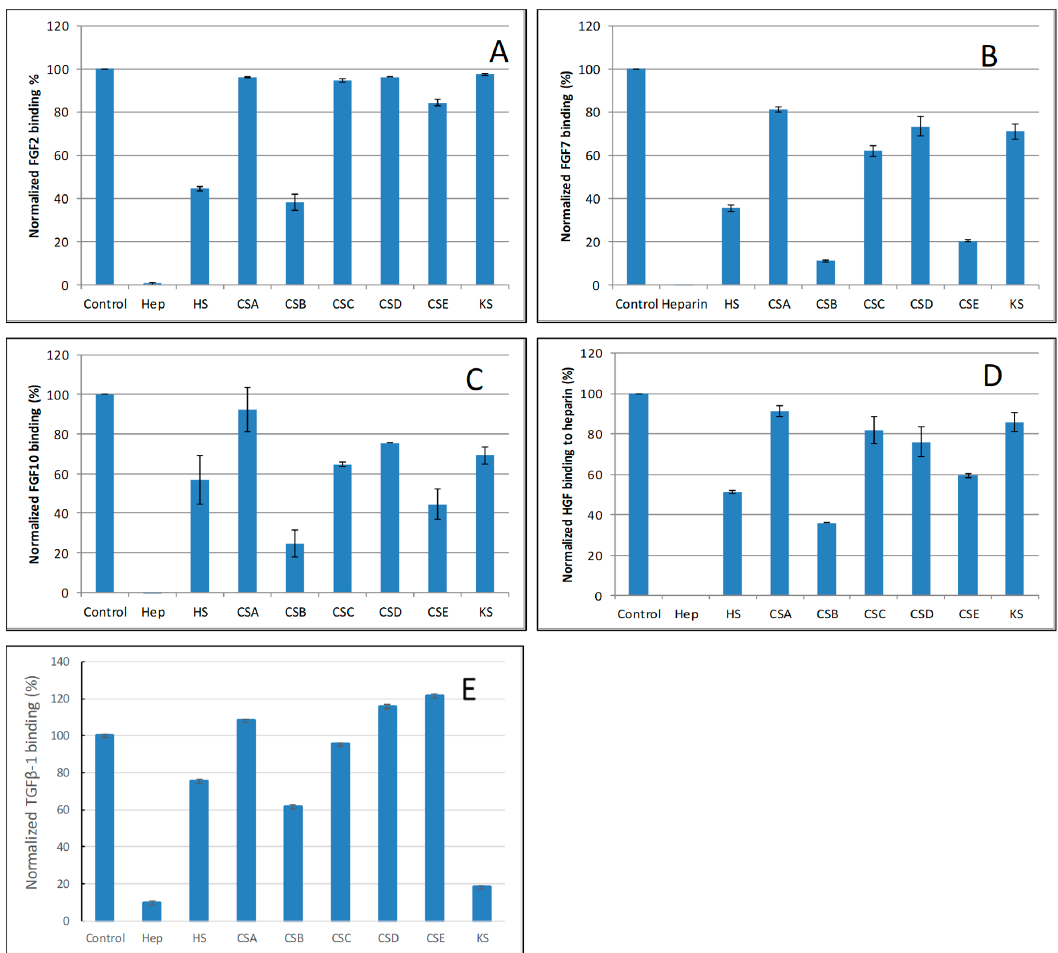
Figure 5. Bar graphs of normalized different growth factors binding preference to surface heparin by competing with different GAGs in solution. ( A ) FGF2, ( B ) FGF7, ( C ) FGF10, ( D ) HGF, ( E ) TGF β -1. Concentrations were 200, 100, 100, 20, and 50 nM for FGF2, FGF7, FGF10, HGF and TGF β -1, respectively and concentrations of GAGs were 1000 nM. All bar graphs based on triplicate experiments.